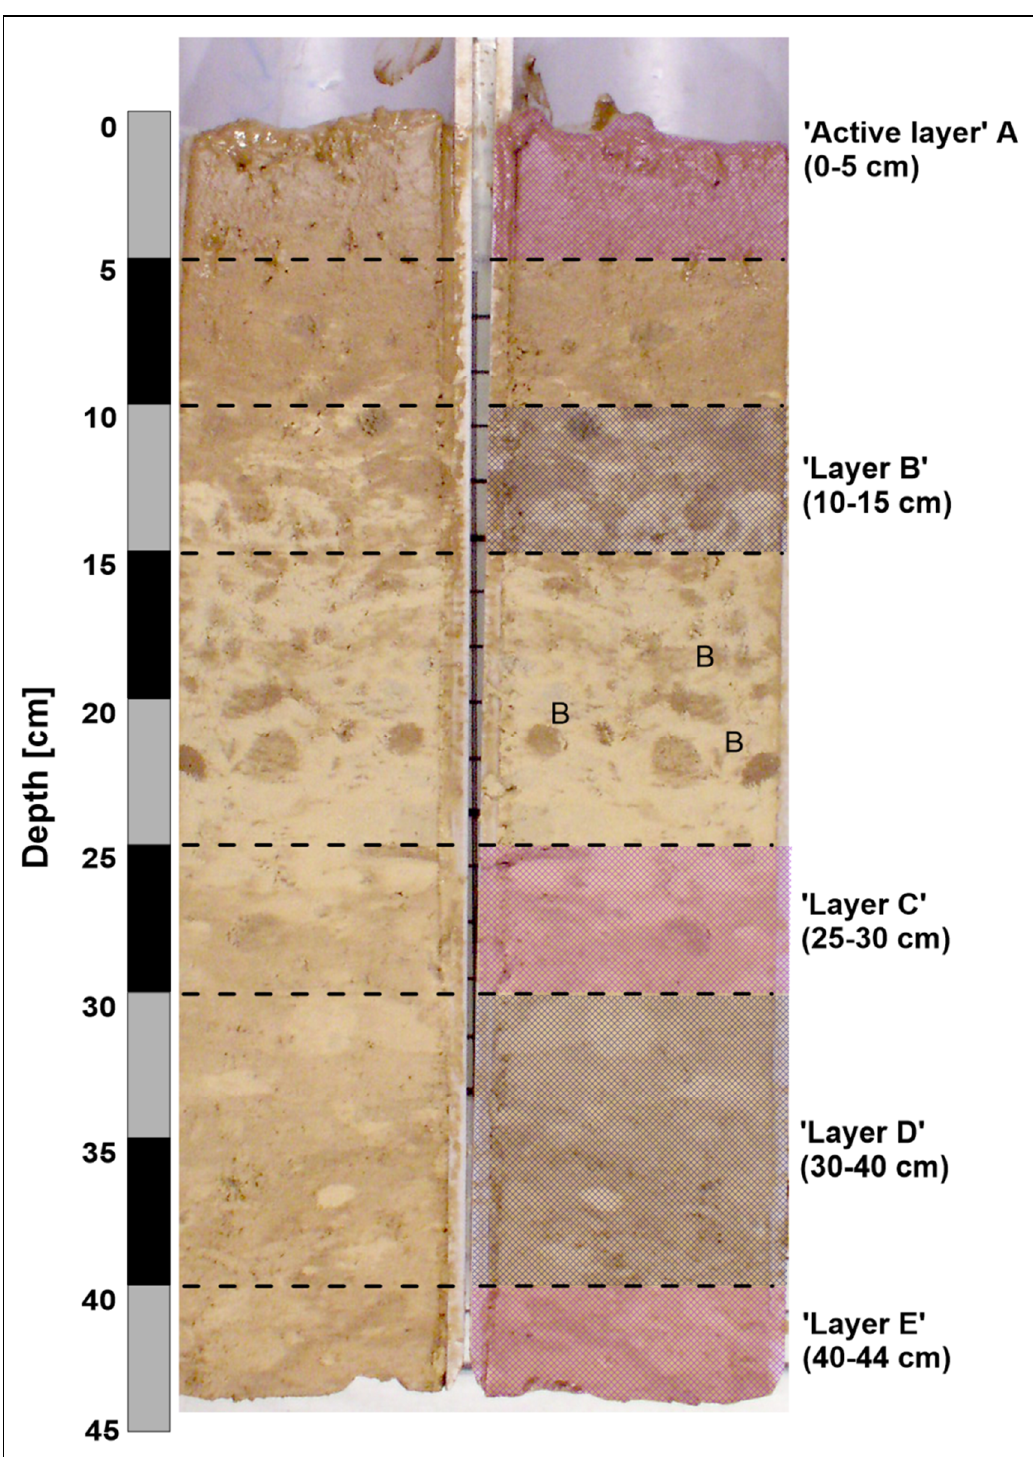
Figure 3. Representative scheme of sampling intervals (station 3515-1). The “B” stands for bioturbations (sediment photos by courtesy of IOM). The “layer” is called a “section”, as explained in the main text. Red and brown signature patterns indicate sediments analysed in this study.